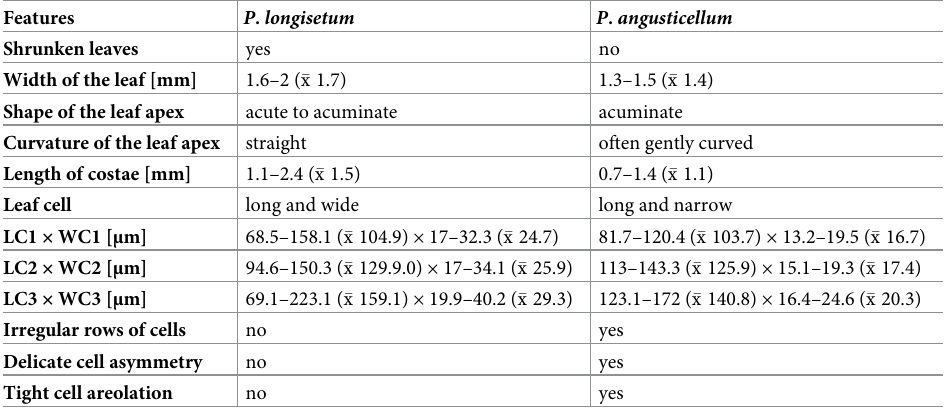
Table 4. Comparison of the main diagnostic features of the described